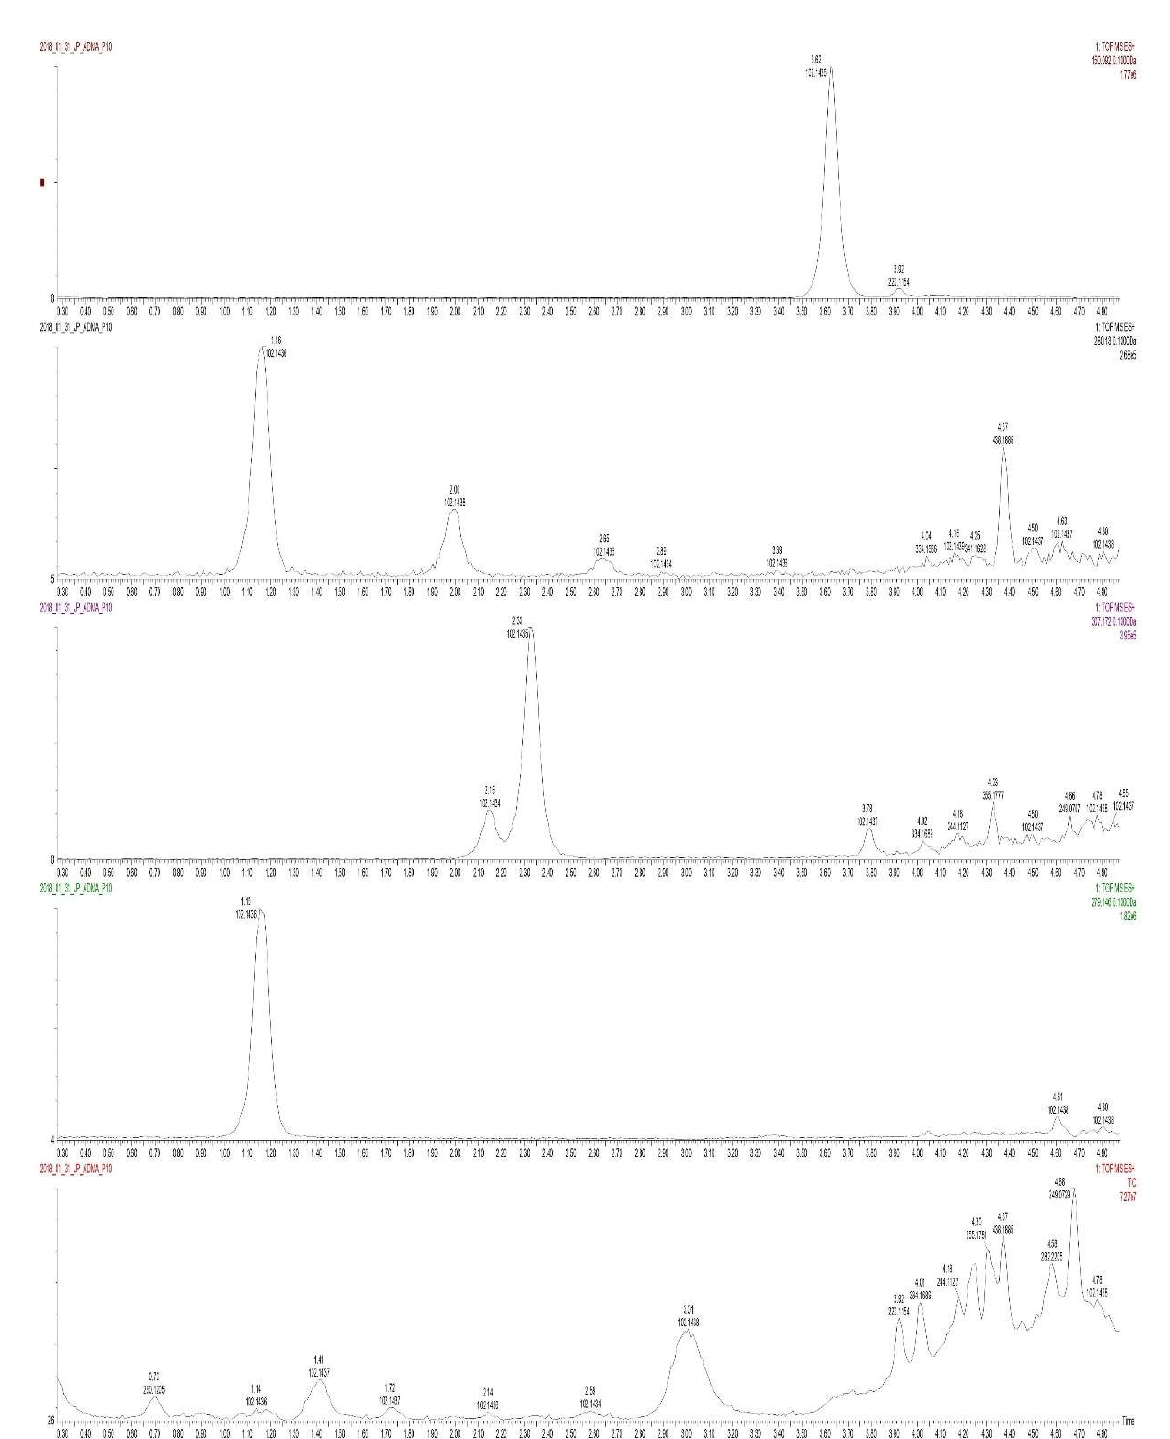
Figure 2. Extracted ion chromatograms for compounds derivatives (from top): DMA, citrulline, ADMA, SDMA, arginine, and total ionic chromatogram (TIC) of a representative patient sample.